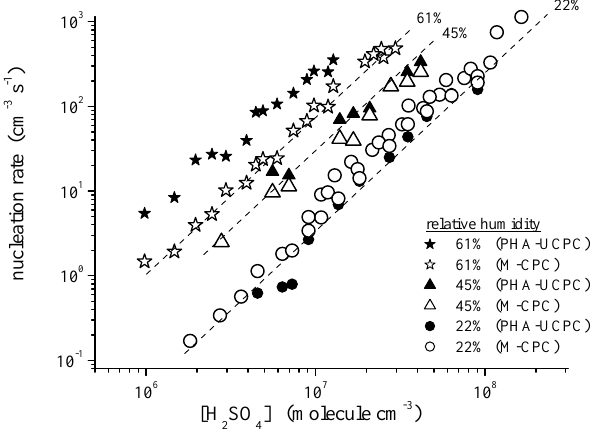
Fig. 7. Nucleation rate as a function of H 2 SO 4 concentration for different RH; total gas flow 11lmin − 1 STP. Measurements have been performed by means of PHA-UCPC and M-CPC. The dashed lines stand for the overall best fit according to Eq. (2a), α =1.86 (H 2 SO 4 ), β =3.08 (H 2